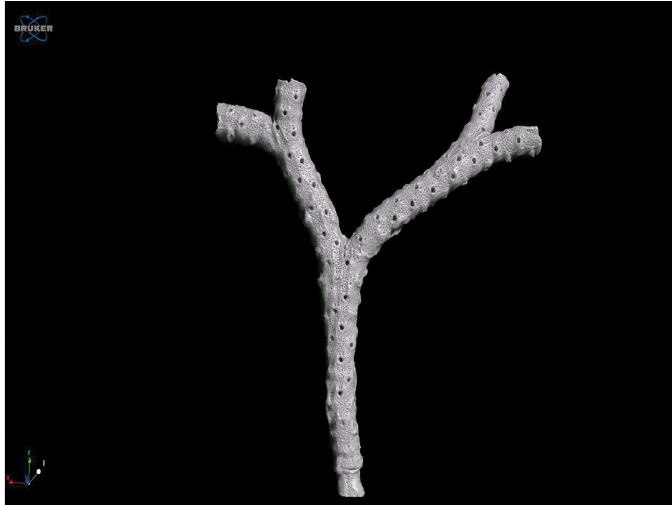
Figure 15. Video of the 3D-model of Smittina directa (Waters, 1904) (MNA 9883). Height and width of the colony are respectively ~17.2 mm and ~16.9